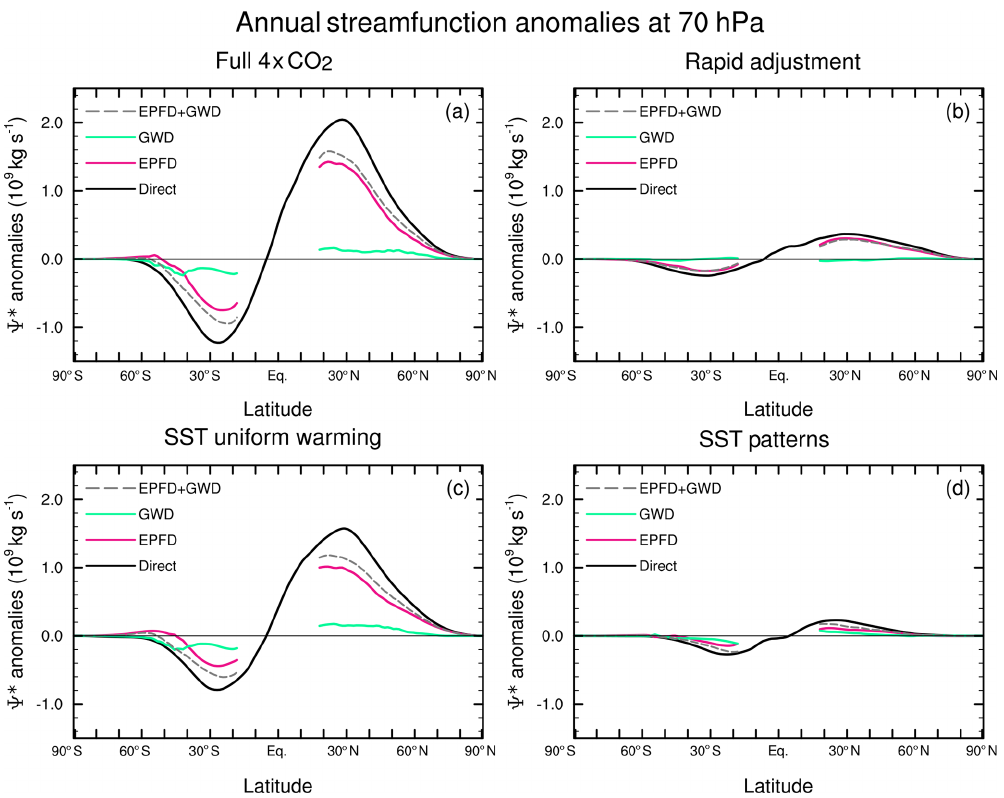
Figure 9. Annual-mean residual streamfunction anomalies (10 9 kgs − 1 ) at 70hPa with respect to the piControl simulation for the (a) 4 × CO 2 (run B), (b) rapid adjustment (run C), (c) uniform SST warming (run D), and (d) SST pattern (run E) experiments. The black line shows the direct calculation, the downward control calculations for EPFD, OGWD + NOGWD, and their sum (EPFD + OGWD + NOGWD) are shown in magenta, green, and grey,